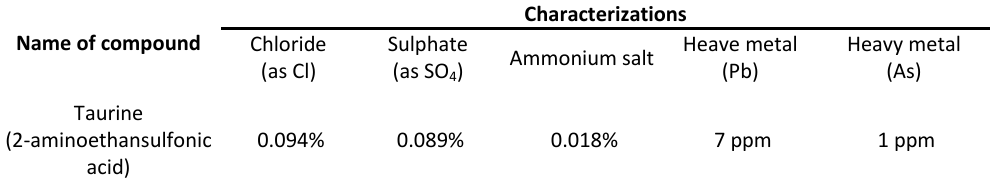
Table 2. Characterization of